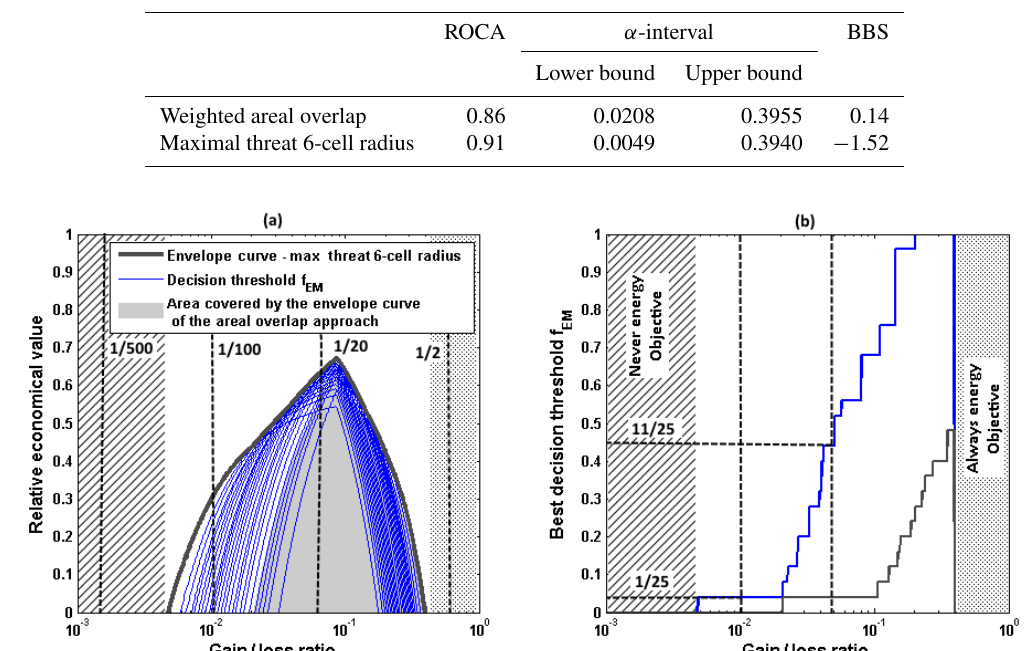
Figure 8. REV curves for the EPS NWP post-processing maximal threat in a radius of 6 grid cells from the catchment ( a , left plot) and best decision threshold according to the α -value ( b , right plot), in blue for the maximal threshold approach and in grey for the areal overlap approach.